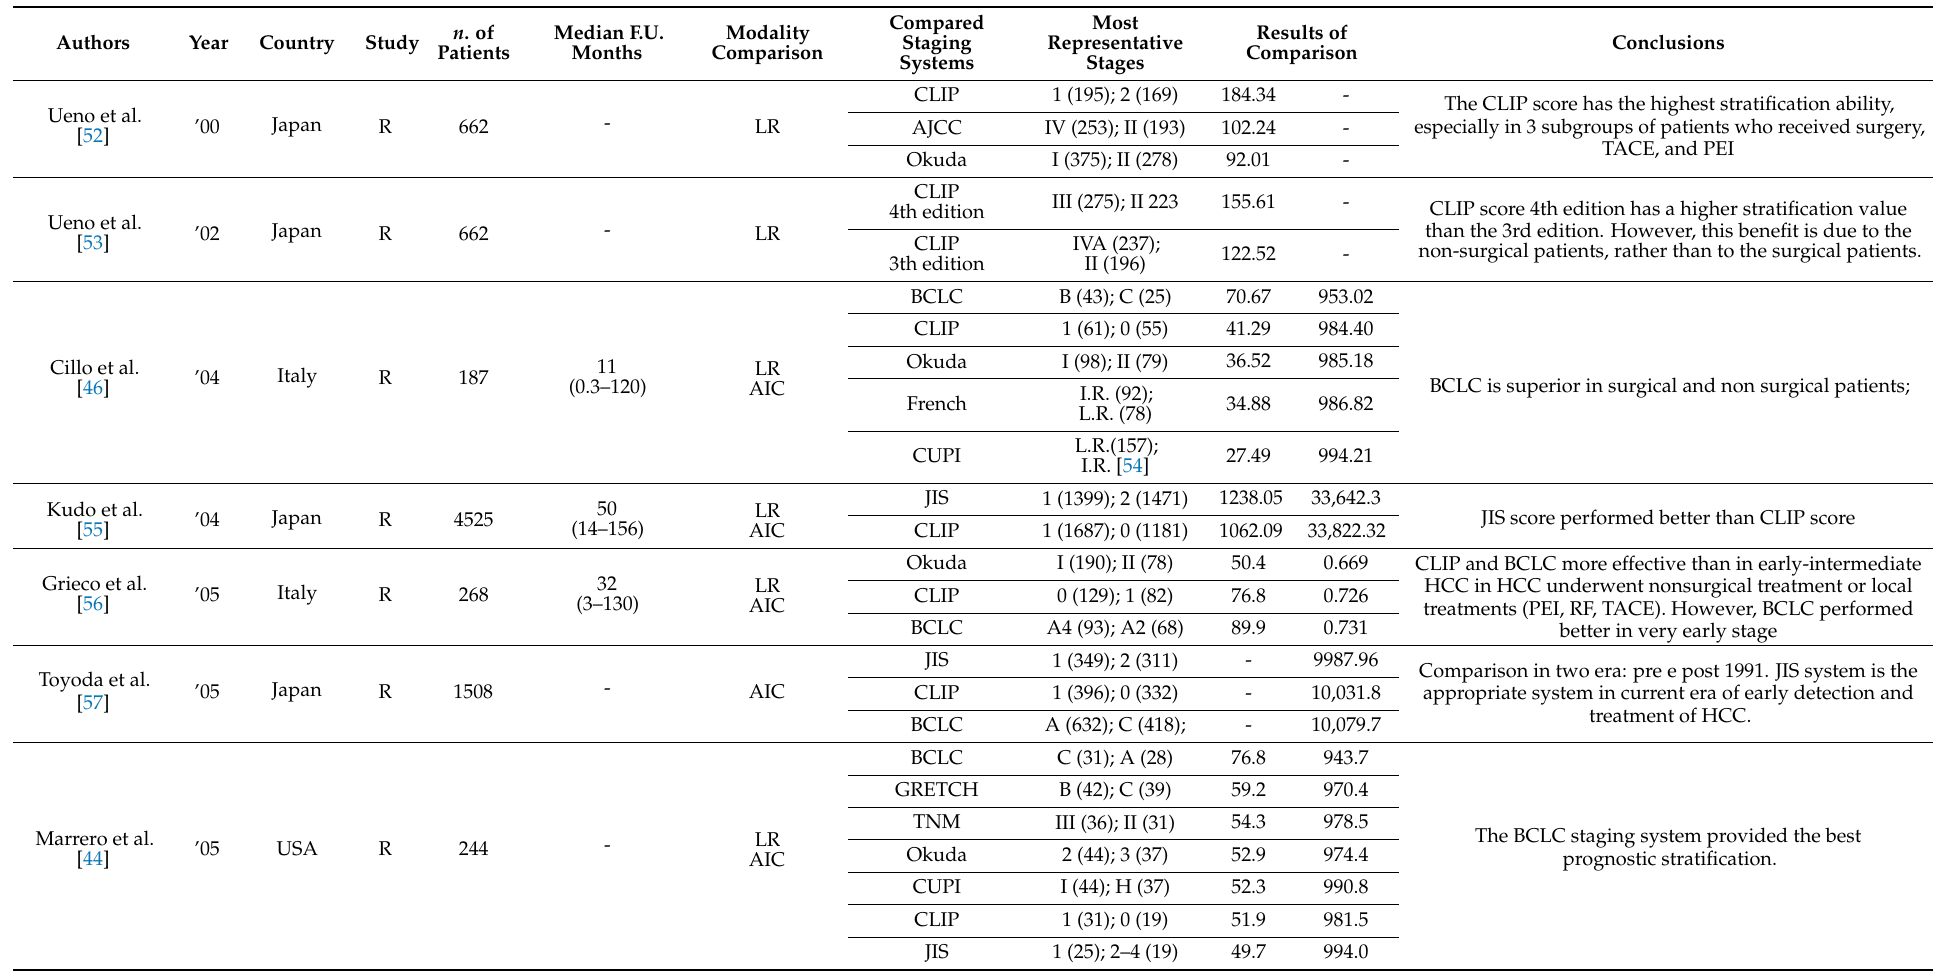
Table 6. Comparison of the prognostic systems in the literature using the LR ratio and AIC